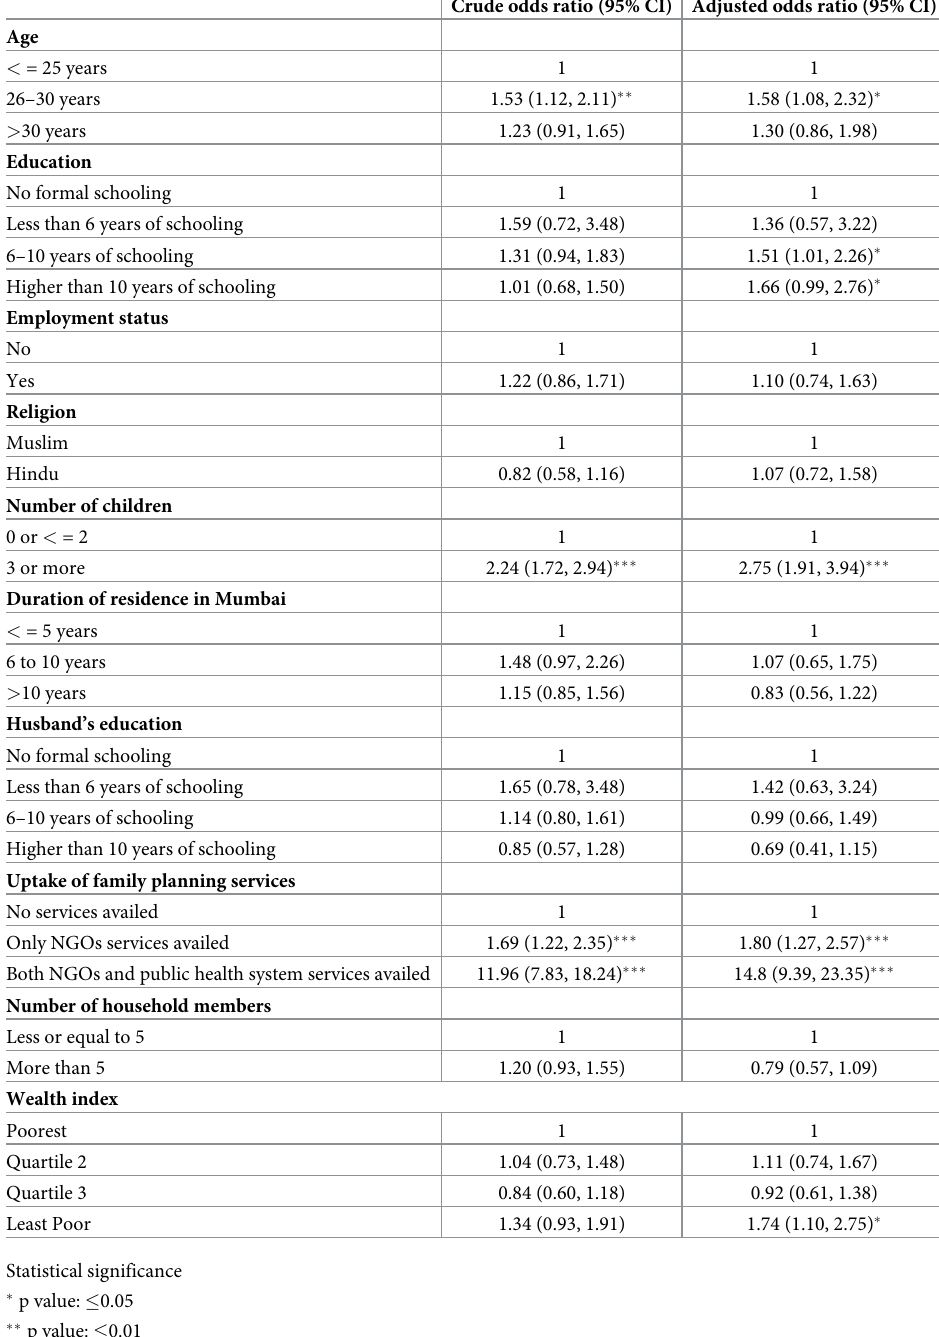
Table 4. Factors associated with the use of modern contraceptive methods by married women of reproductive age (15–49 years) in urban informal settlements of Malvani,